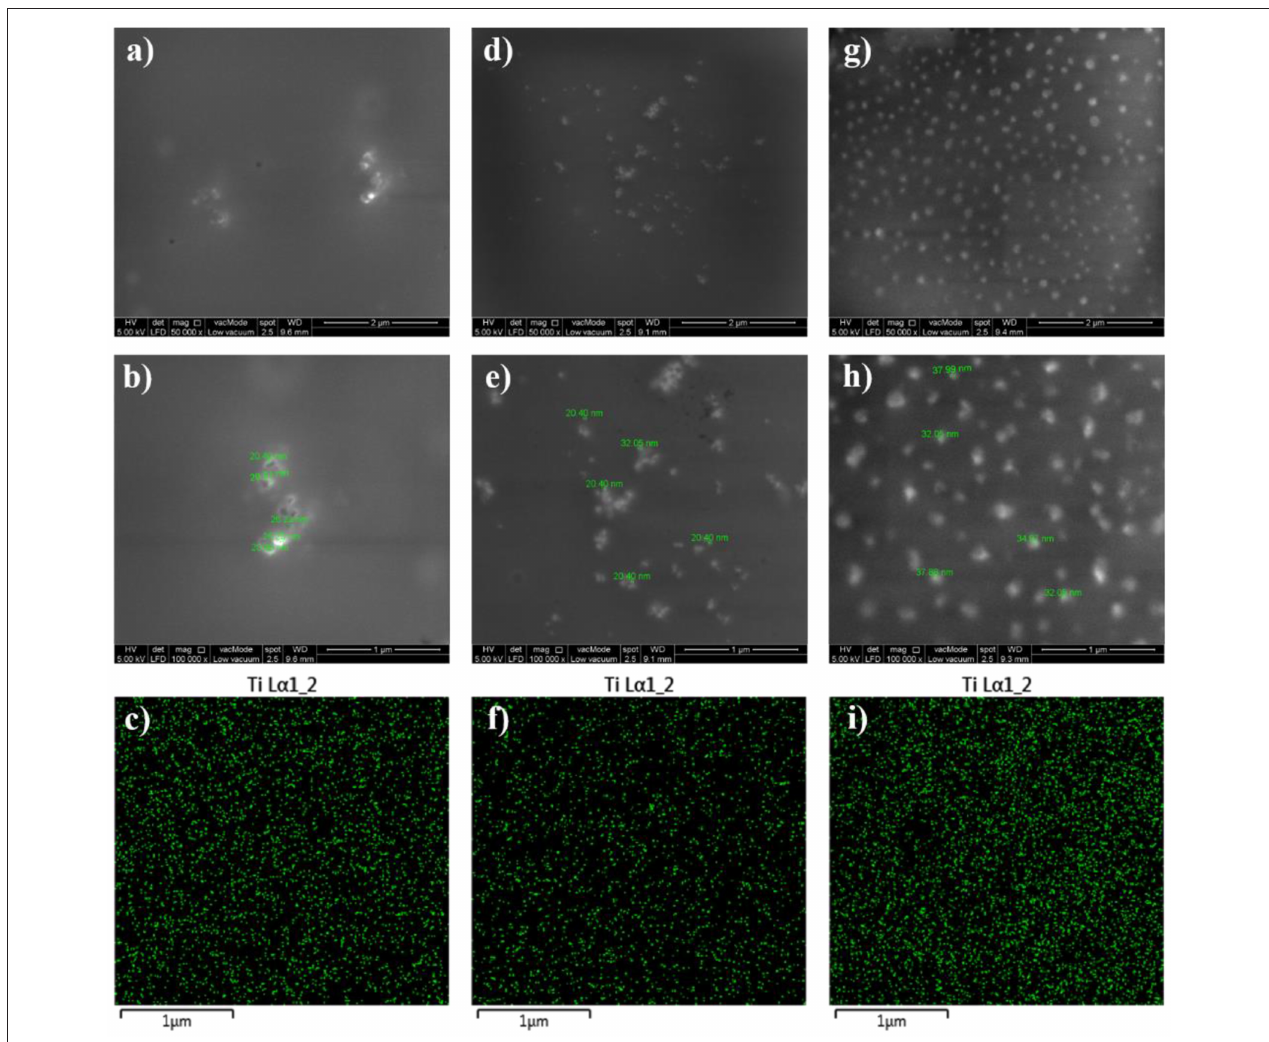
FIGURE 3 | FESEM images at x50000 and x100000 magnifications together with EDX mapping images for EPT1 (a–c) , EPT2 (d–f) , and EPT3 (g–i)